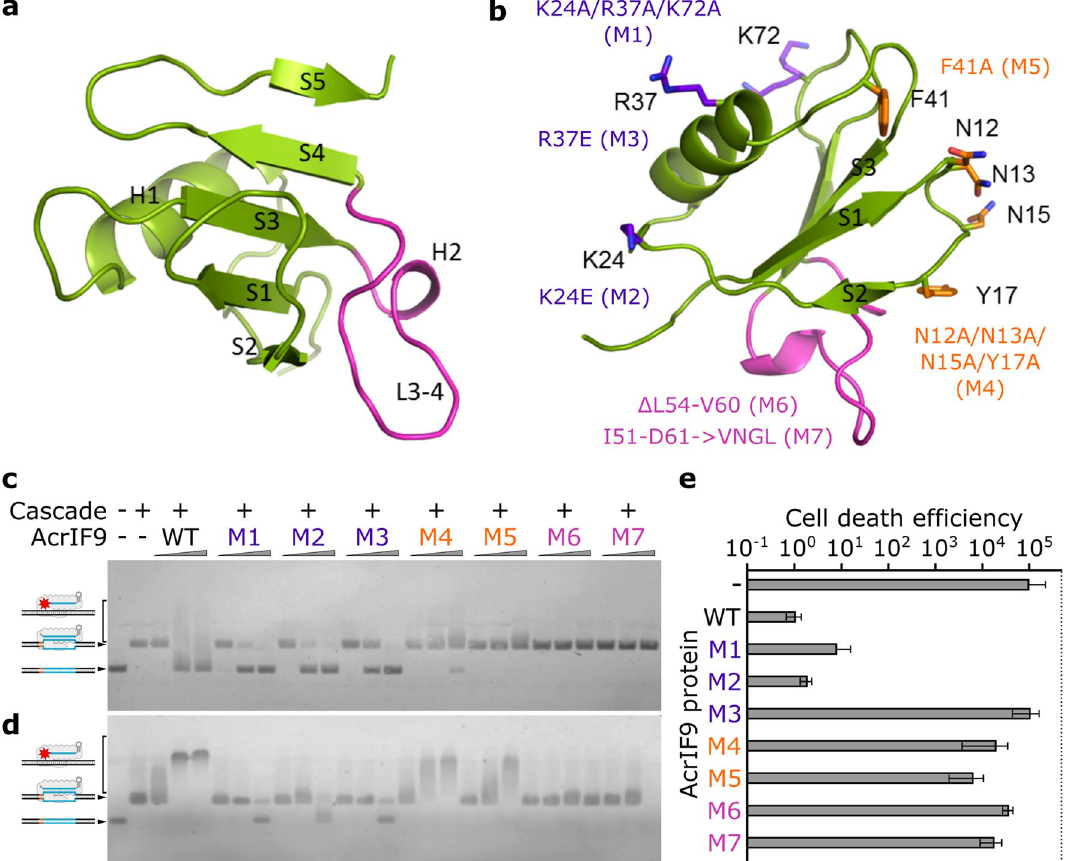
Figure 5. Crystal structure of AcrIF9. ( a ) The overall structure of Aa1-AcrIF9. The secondary structure elements are labelled. ( b ) Cascade and DNA interaction surfaces. Residues of Aa1-AcrIF9 potentially interacting with Cascade and DNA are shown in stick representation and coloured orange and purple, respectively. The loop L3-4 is coloured magenta. Mutants of the corresponding residues are indicated. ( c , d ) Cascade binding to the DNA target in the presence of the AcrIF9 mutants. The increasing concentrations of the AcrIF9 mutant proteins (50, 500, 5000 nM) were incubated with either 20 nM ( c ) or 100 nM ( d ) Cascade and then introduced to the binding buffer containing 20 nM target DNA. Protein interactions with the DNA were assayed by EMSA in agarose gel. ( e ) In vivo inhibition of Aa-CRISPR-Cas by the AcrIF9 mutants. The respective AcrIF9 mutants were co-expressed with the Aa-CRISPR-Cas system either targeting or non-targeting the E. coli genome. Empty vector (–) was used as a control. The ratio of transformation efficiencies of non-targeting and targeting